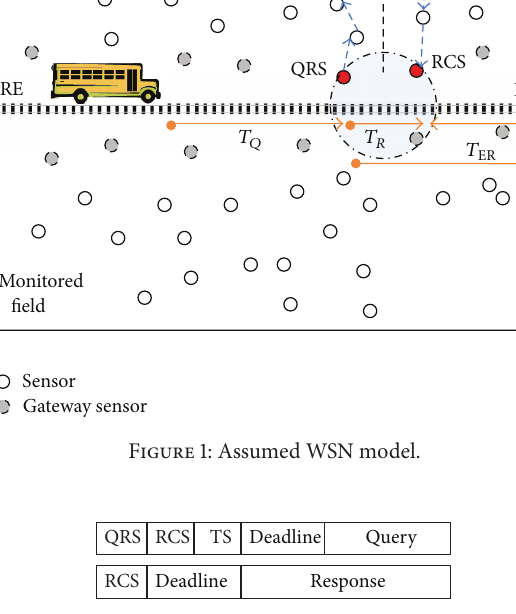
Figure 2: Query and response message